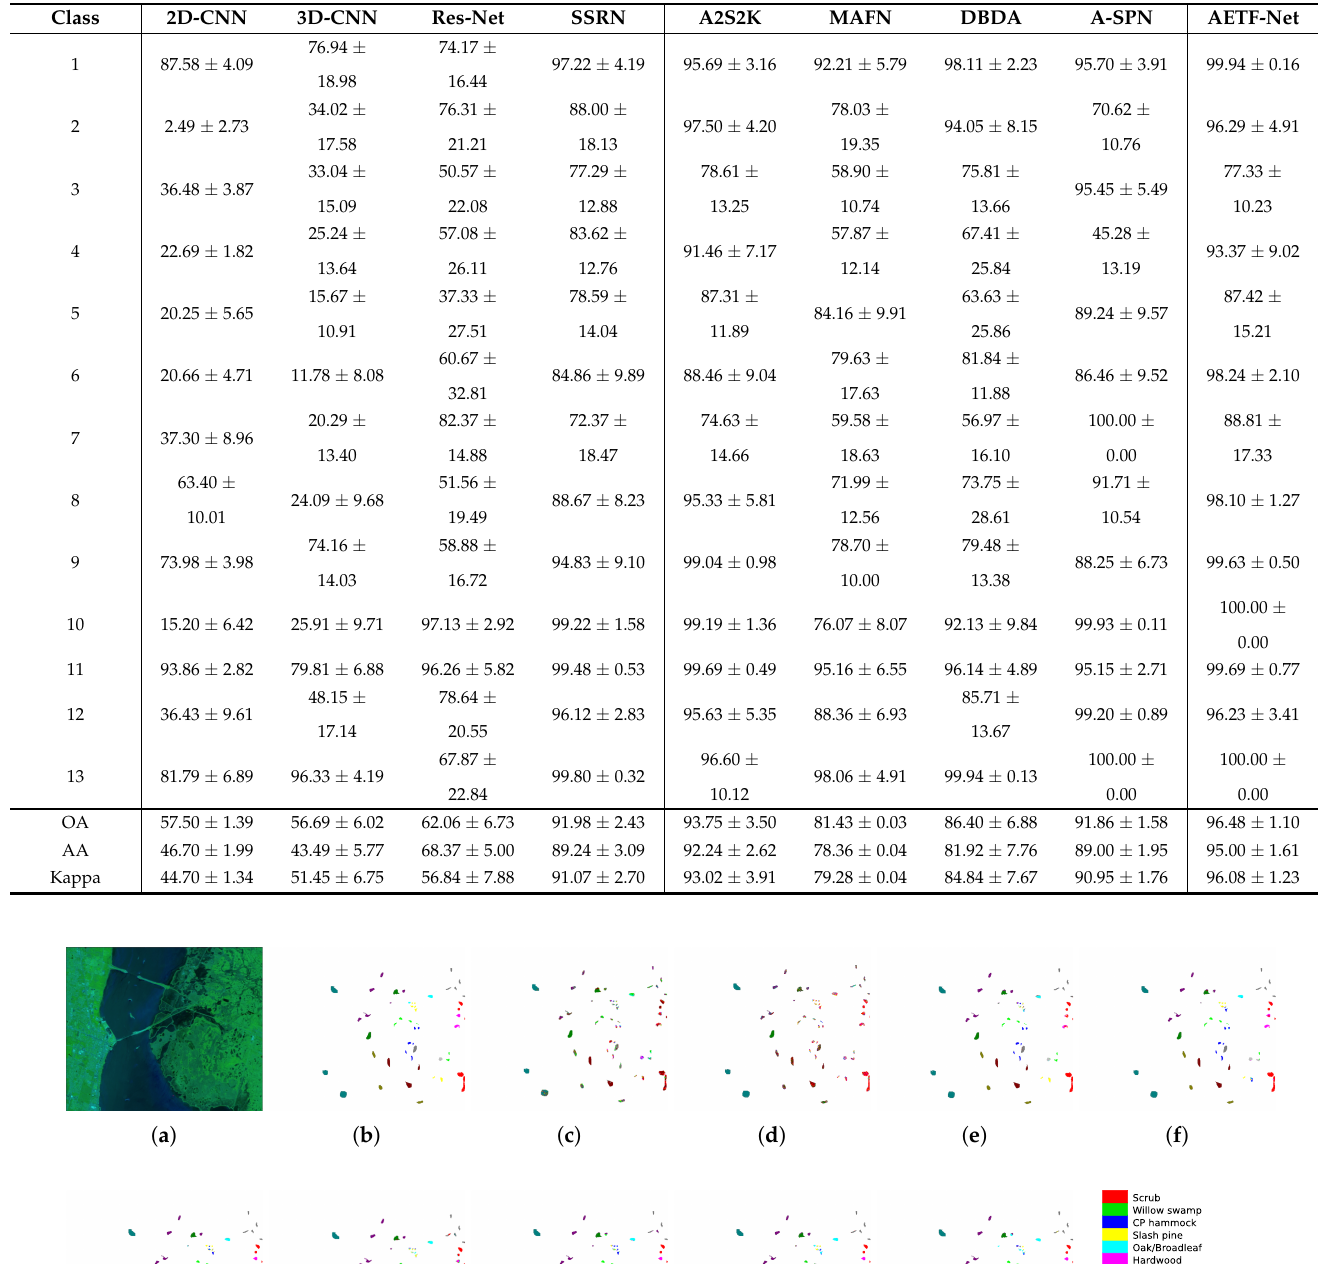
Table 7. The classification results (%) of all compared methods on the KSC dataset.